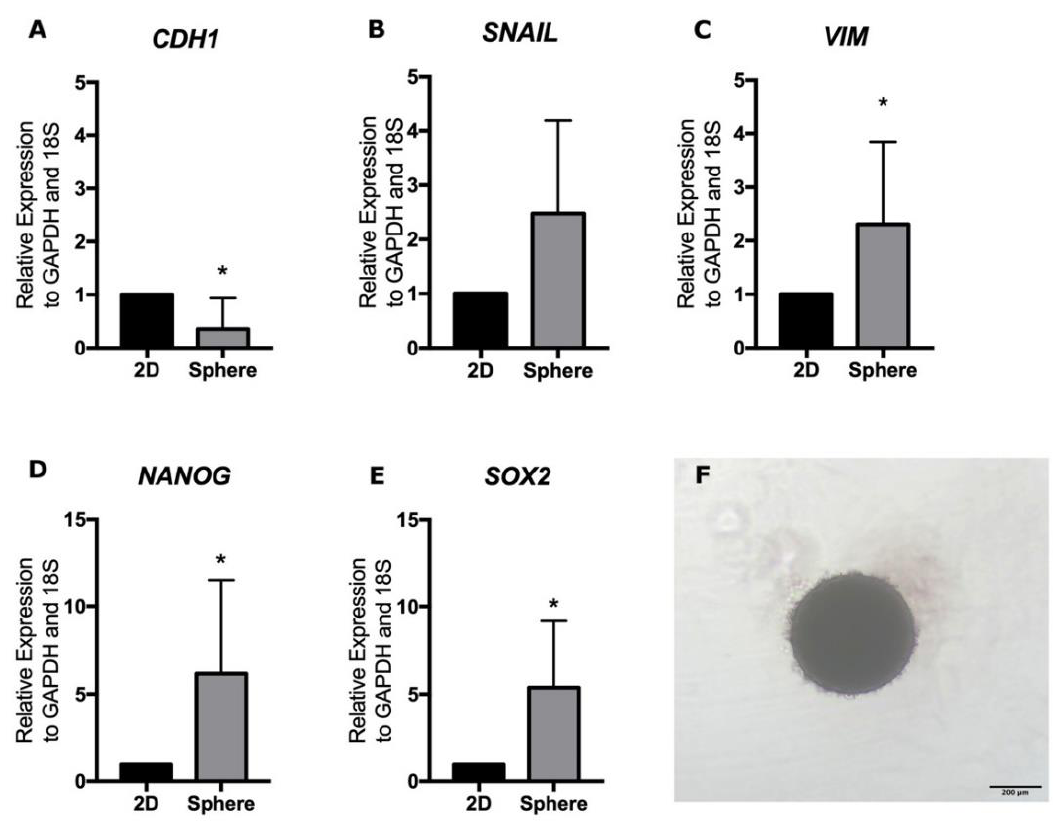
Figure 3. Characterization of trophospheres after 72 h culture compared to 2D adherent culture. mRNA expression of CDH1 ( A ), SNAIL ( B ), VIM ( C ), NANOG ( D ) and SOX2 ( E ) in trophospheres and 2D cultures was analyzed by qRT-PCR and normalized to GADPH and 18S housekeeping genes. ( F ) Tropho-sphere following 72 h of culture. Results are expressed as mean and SD of seven trophospheres and HTR-8/SVneo monolayer cultures per group. * p < 0.05. Statistical analyses were performed by using the Wilcoxon matched-pairs signed-rank test. SD, standard deviation.